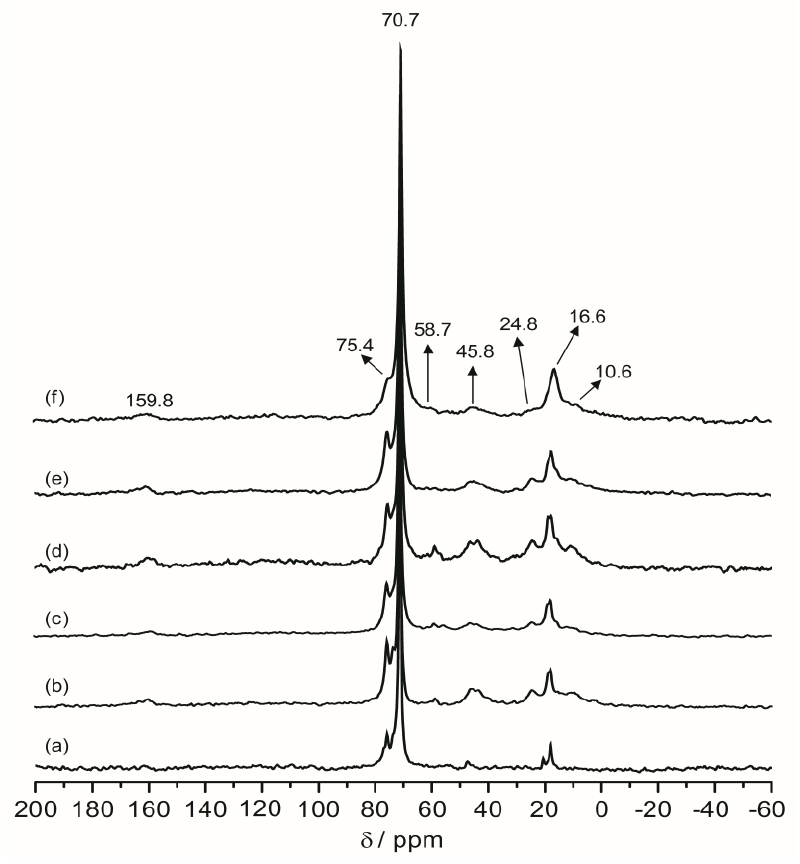
Figure 4. 13 C CPMAS NMR spectra of ( a ) pure ED2000 and TIE(2000)-Z hybrid electrolytes with Z = ( b ) ∞ , ( c ) 32, ( d ) 24, ( e ) 16 and ( f )